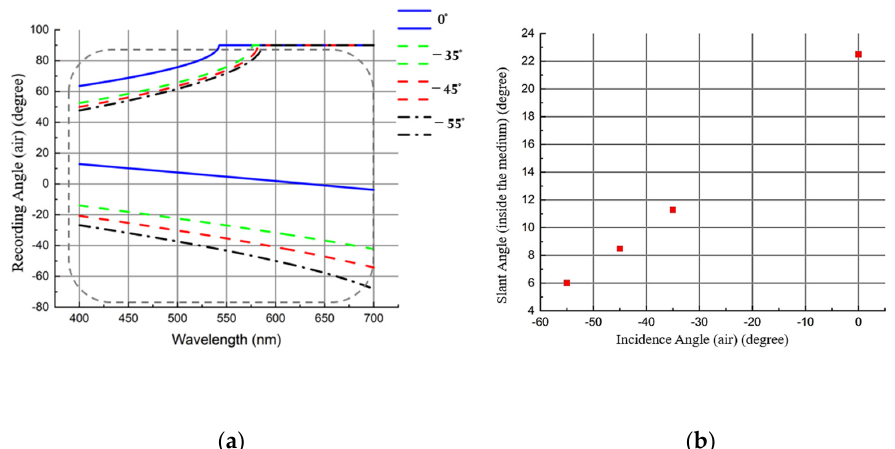
Figure 4. ( a ) Recording angles for both recording beams (in air) vs. recording wavelengths for four HOE couplers designed for 633 nm with incident angles (in air) of 0 ° , − 35 ° , − 45 ° and − 55 ° (the dotted box shows the practically achievable angles). ( b ) Slant angle for each of the four HOE couplers. In all cases, the diffraction angle is such that the 633 nm beam is incident internally at +45 ° and thus is totally internally reflected.